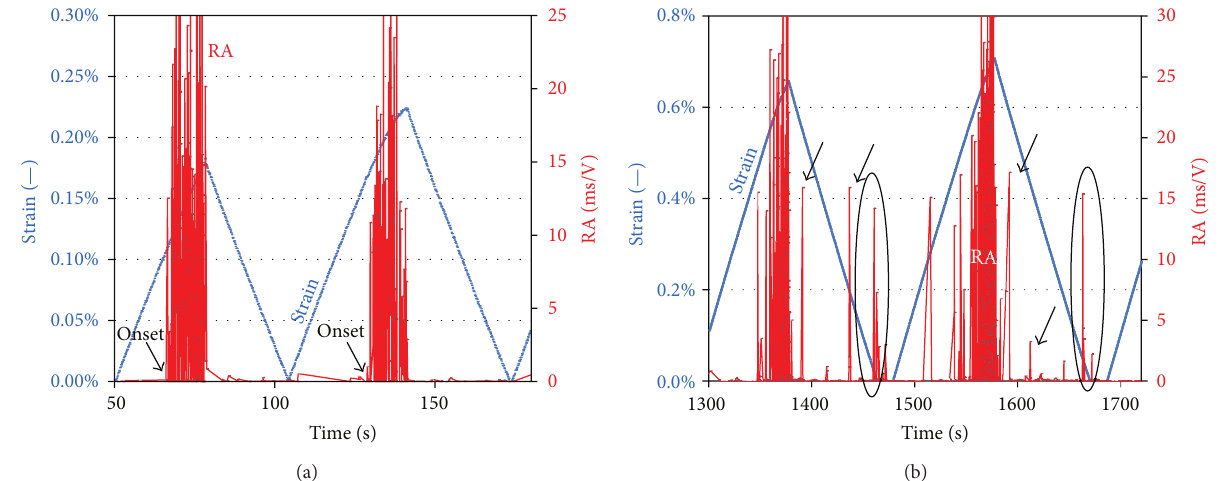
Figure 5: Extension history and RA values for specimen C: (a) 3rd and 4th cycles and (b) 12th and 13th